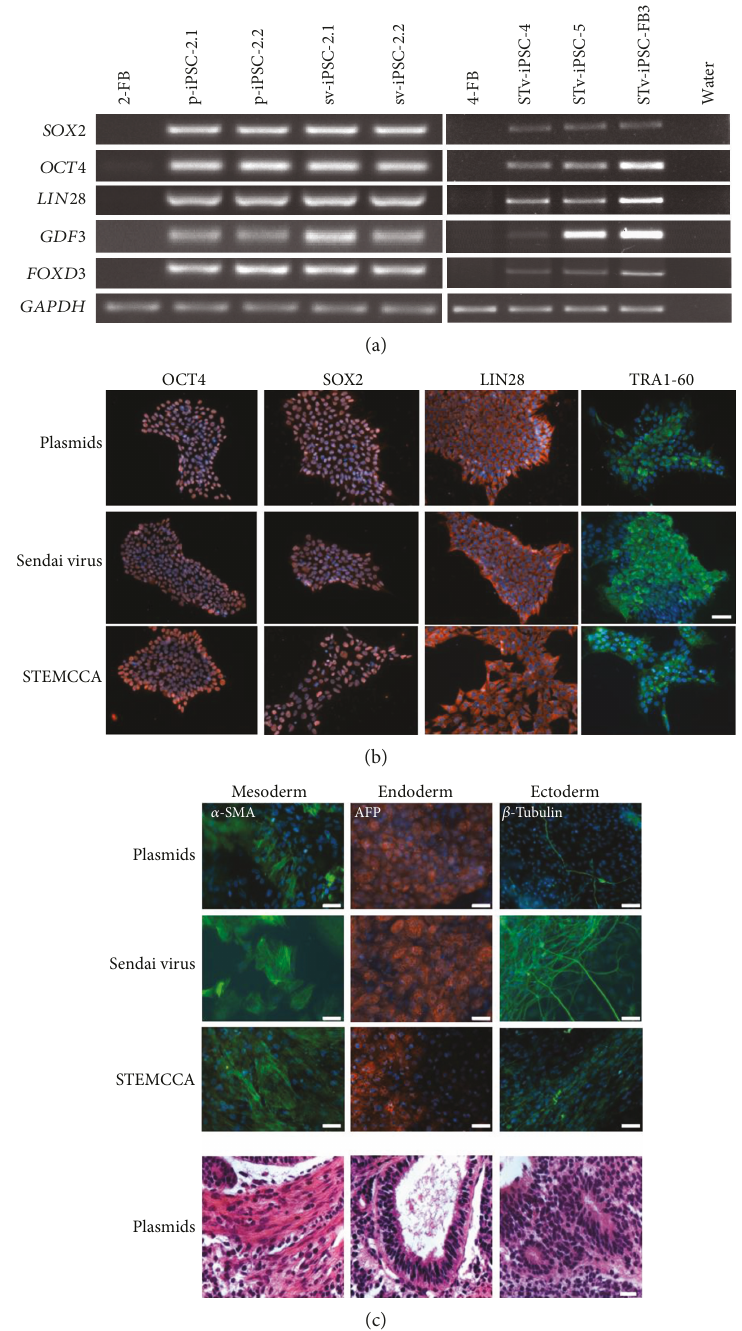
Figure 2: Generated iPSCs are pluripotent. (a) The iPSC lines (representative for di ff erent reprogramming methods as episomal plasmids, Sendai virus, and STEMCCA) express endogenous pluripotency marker SOX2 , OCT4 , LIN28 , GDF3 , and FOXD3 genes at the mRNA level, which was shown by RT-PCR. iFB5 cells were used as the positive control for pluripotent iPS cells [13]. 2-FB and 4-FB are fi broblast before reprogramming. Water was used as the negative control. All other mentioned cell lines are iPSCs. (b) Expression of pluripotency markers OCT4, SOX2, LIN28, and TRA1-60 as shown by immuno fl uorescence staining. Scale bar: 50 μ m. (c) Spontaneous di ff erentiation capacity in vitro via embryoid bodies (EBs) of three iPSC lines, representative of each reprogramming method. Immunocytochemical staining was used for analysis of di ff erentiation capacity by protein expression of mesodermal α -SMA, endodermal α -fetoprotein (AFP), and ectodermal β III-tubulin exemplarily in one iPSC line generated by each reprogramming method. Scale bar: 100 μ m. IPSC colonies were used for teratoma formation in immunode fi cient mice to test the developmental potential of iPSCs in vivo. Representative pictures of mesodermal, endodermal, and ectodermal tissues are shown from one cell line generated by the plasmid reprogramming method. Scale bar: 20 μ m. GAPDH was used as the loading control (a). Nuclear localization was marked with DAPI (blue) (b,